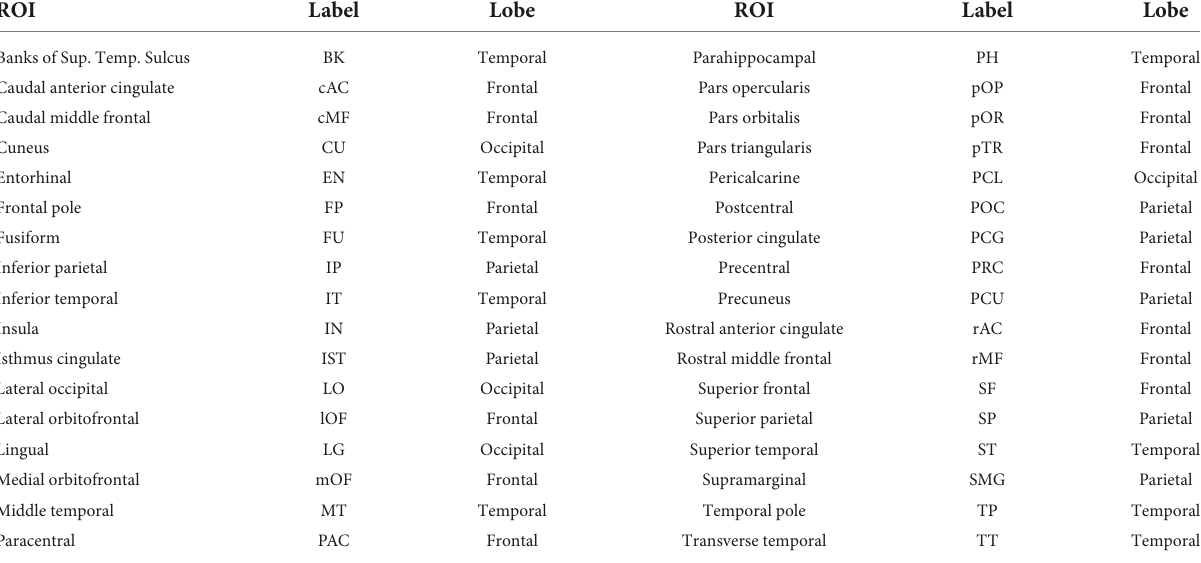
TABLE 1 The approximate mapping of the “Desikan-Killiany” ROIs to the lobes. ROI Label Lobe ROI Banks of Sup. Temp.